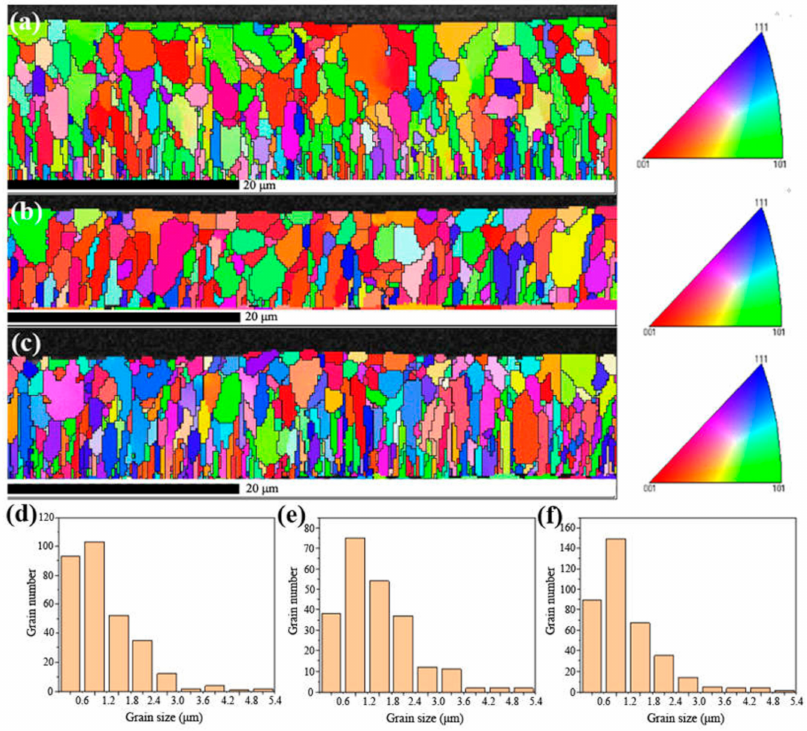
Figure 4. The EBSD reconstruction map and the grain size distribution of the coating samples.